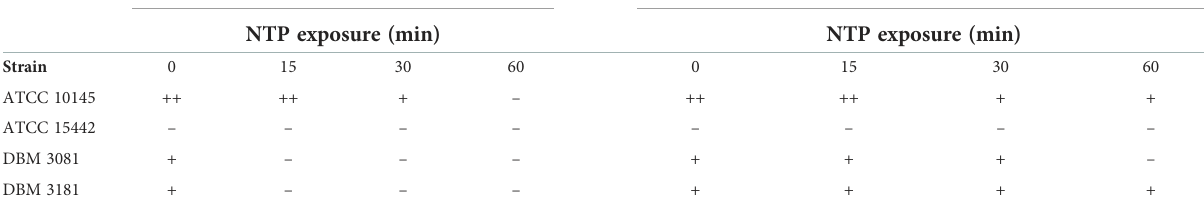
TABLE 1 Effect of NTP on pyocyanin production by bio fi lm cells and cells dispersed from bio fi lm of Pseudomonas aeruginosa determined by cultivation on King A agar plates. Pyocyanin production by bio fi lm